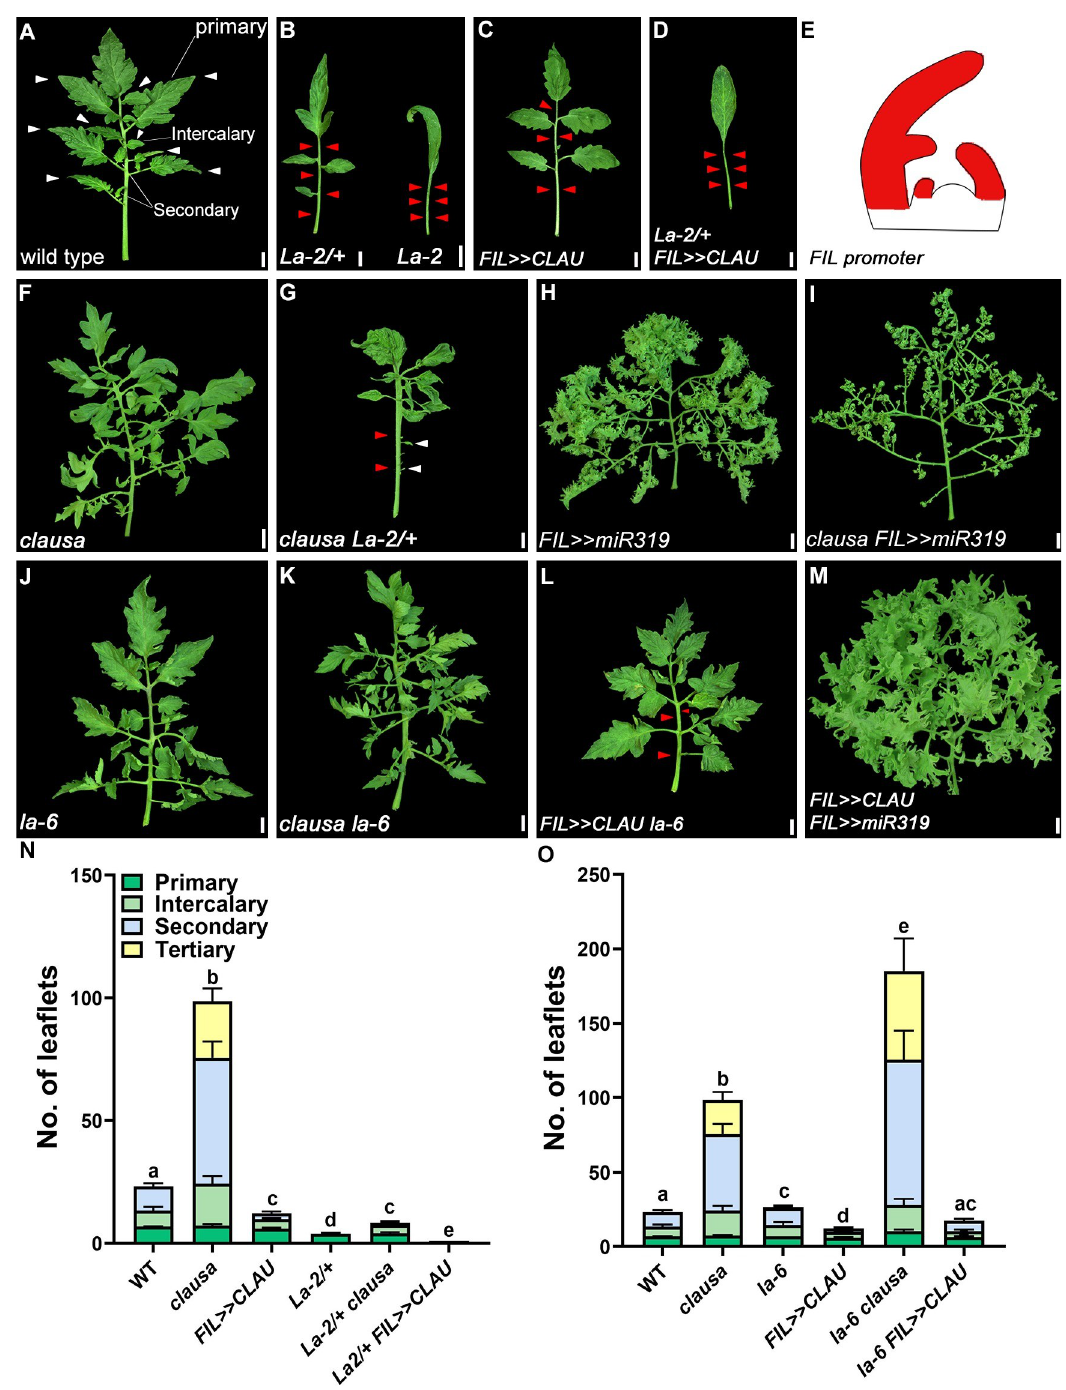
Fig 1. CLAU and LA function in parallel pathways. (A-D, F-M) Genetic interactions between genotypes with altered CLAU and LA expression levels. La-2/+ : a semi-dominant LA allele with increased and precocious expression due to miR319 resistance. La-6 , FIL >> miR319 : LA null or LA downregulation, respectively. clausa : CLAU null. FIL >> CLAU : CLAU upregulation. All leaves depicted are fully expanded fifth leaves. Bars = 1 cm. White and red arrowheads represent primary leaflets and missing primary and intercalary leaflets, respectively. (E) Cartoon depicting the expression domain of the FIL promoter. (N-O) Quantification of leaf complexity in genotypes with altered CLAU and LA expression levels. Graphs represent mean ± SE of six independent biological repeats. Different types of leaflets are indicated according to the color code. Statistical significance of differences in the total